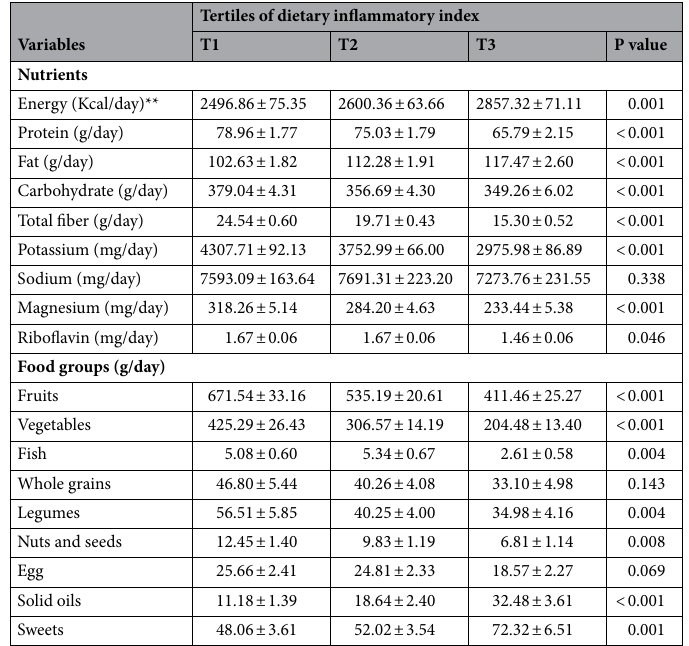
Table 2. Selected food groups and nutrients intake of participants across tertiles of dietary inflammatory index*. Data are presented as mean ± standard error and obtained from analysis of variance (ANOVA). P < 0.05 was considered statistically significant. *All values have been adjusted for total energy intake using a residual method. **Energy intake was not adjusted.